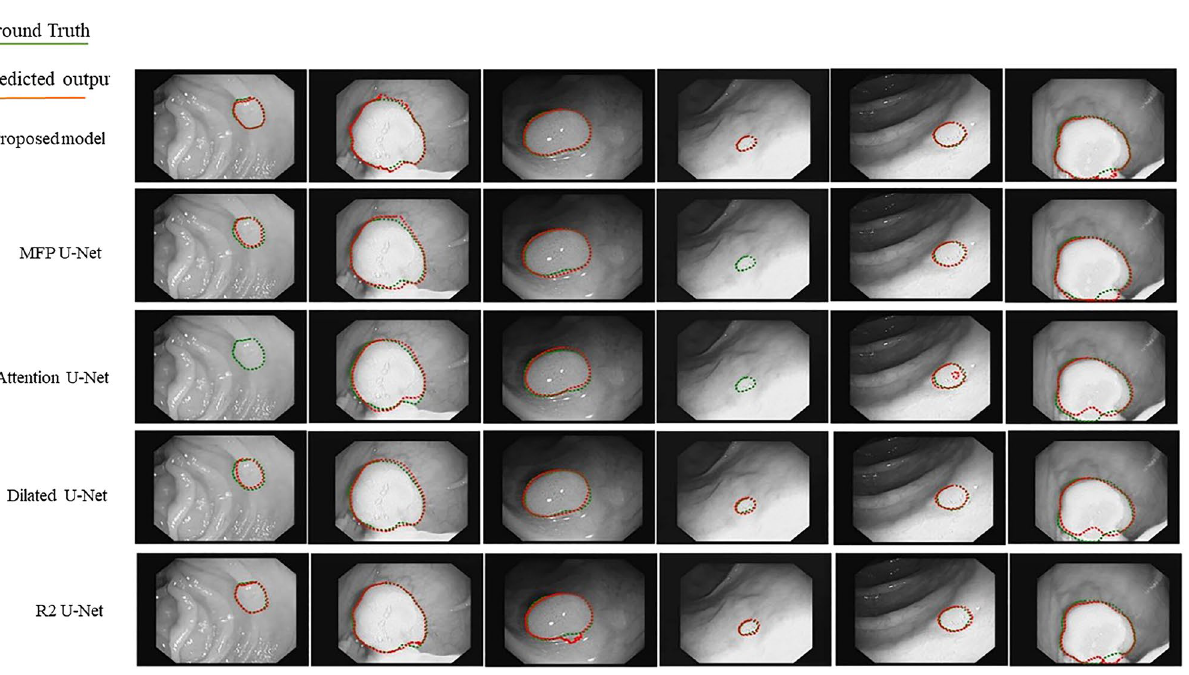
Figure 12. Representative results of segmentation achieved by the proposed model in comparison with other U-Net based models on CVC-ClinicDB